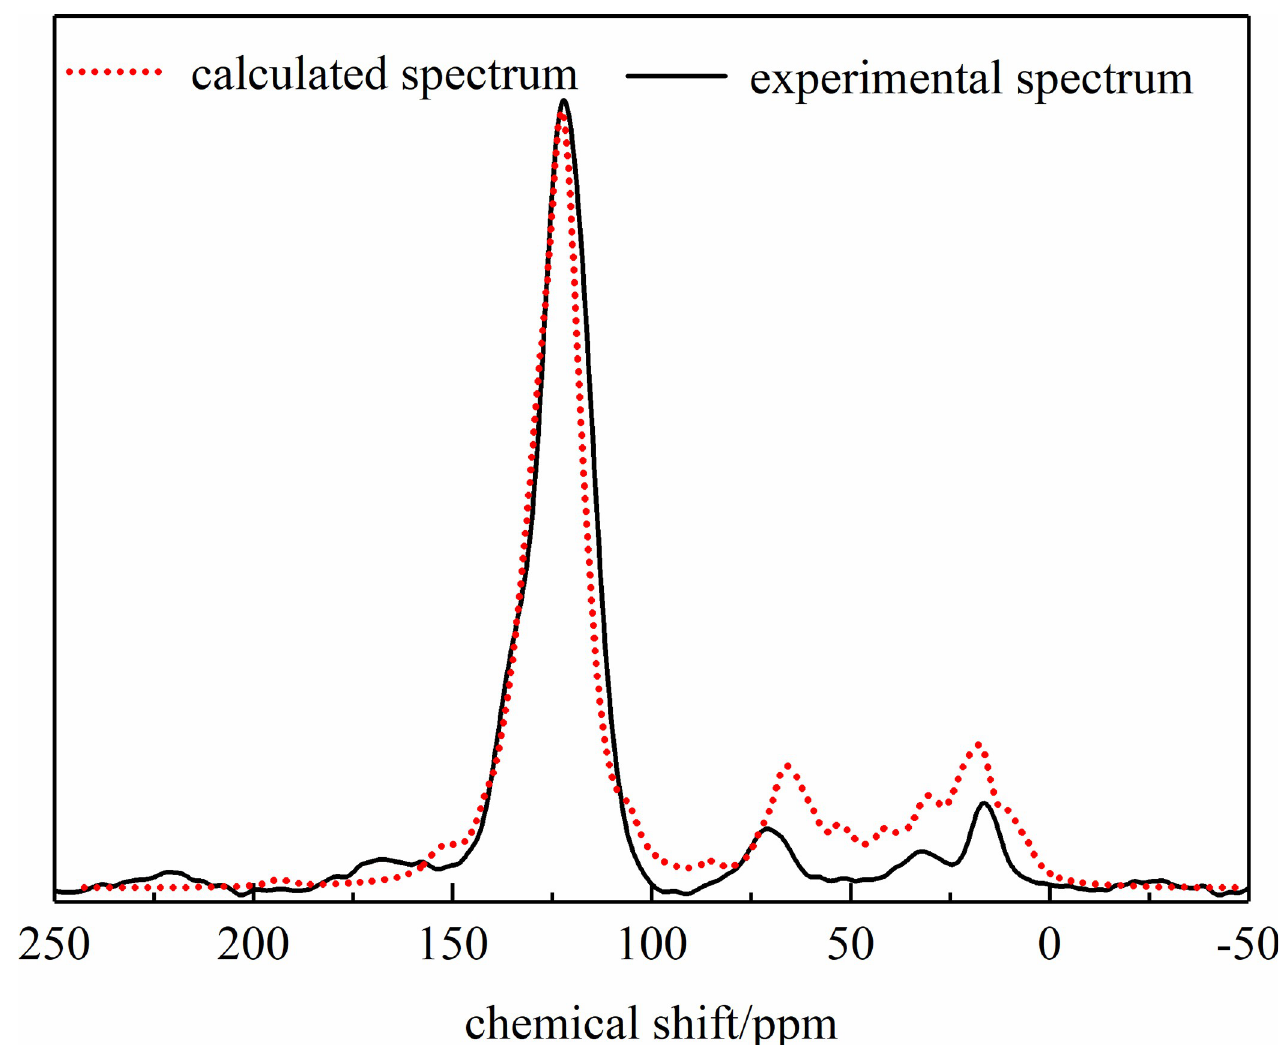
Fig 10. Comparison of 13C NMR experimental spectra and model predictive spectra of